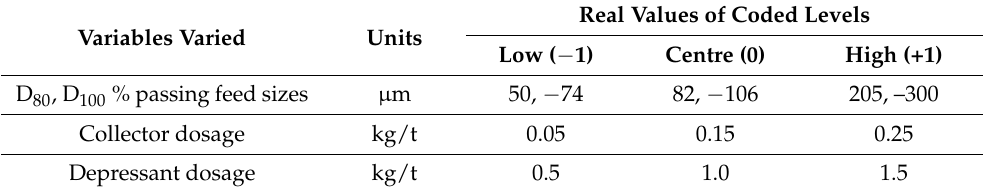
Table 3. List of variables and their